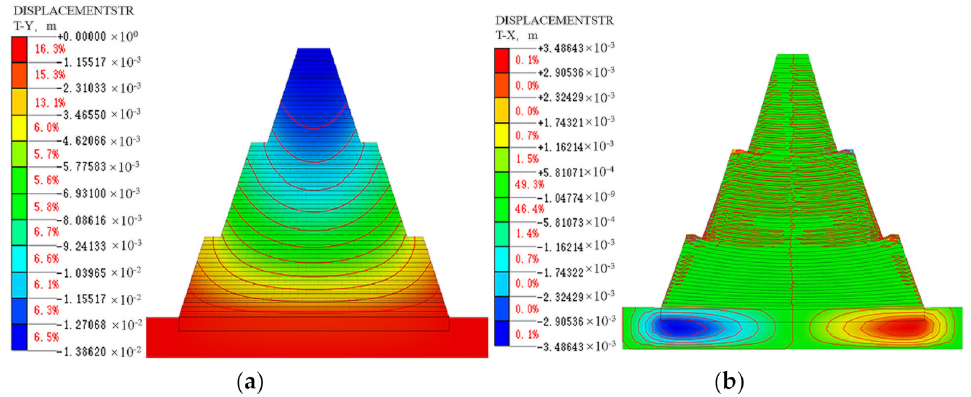
Figure 11. Vertical and horizontal displacement cloud images: ( a ) vertical displacement cloud diagram; ( b ) horizontal displacement cloud diagram.